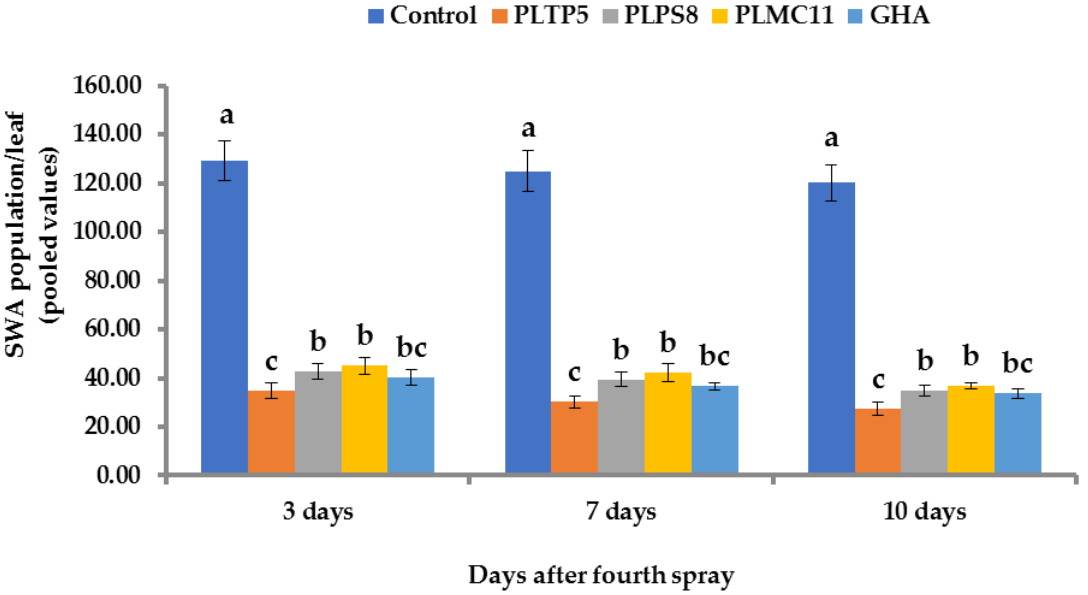
Figure 7. Population of C. lanigera per leave treated with 1 × 10 8 conidia mL −1 of EPF isolates, recorded at different time intervals after fourth spray. Different letters (a–c) in columns indicate significant differences ( p ≤ 0.05) among the isolates. Columns represent the mean ± SD ( n = 3). SD = standard deviation.